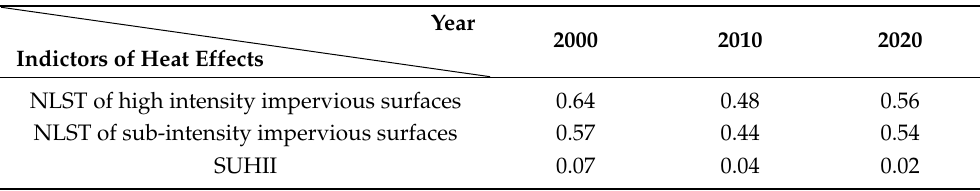
Table 3. Statistical description of the surface urban heat island intensity (SUHII) in Hangzhou City from 2000 to 2020.